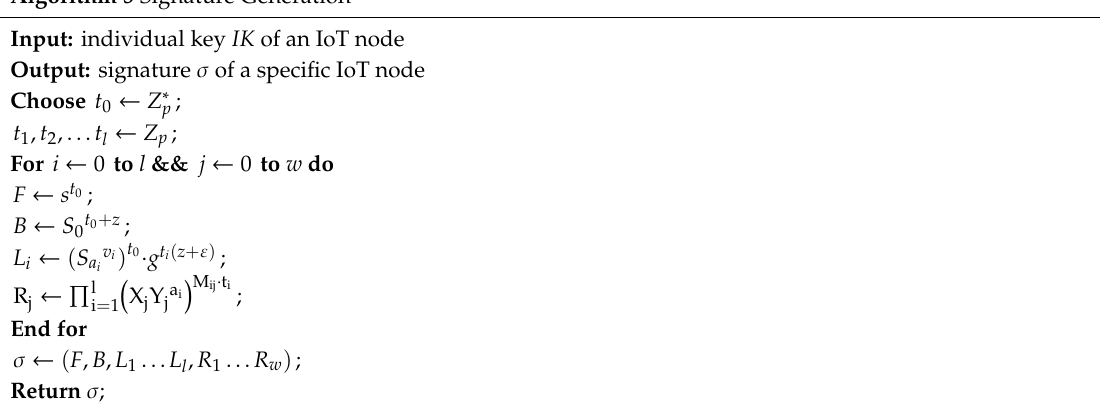
Algorithm 5 Signature